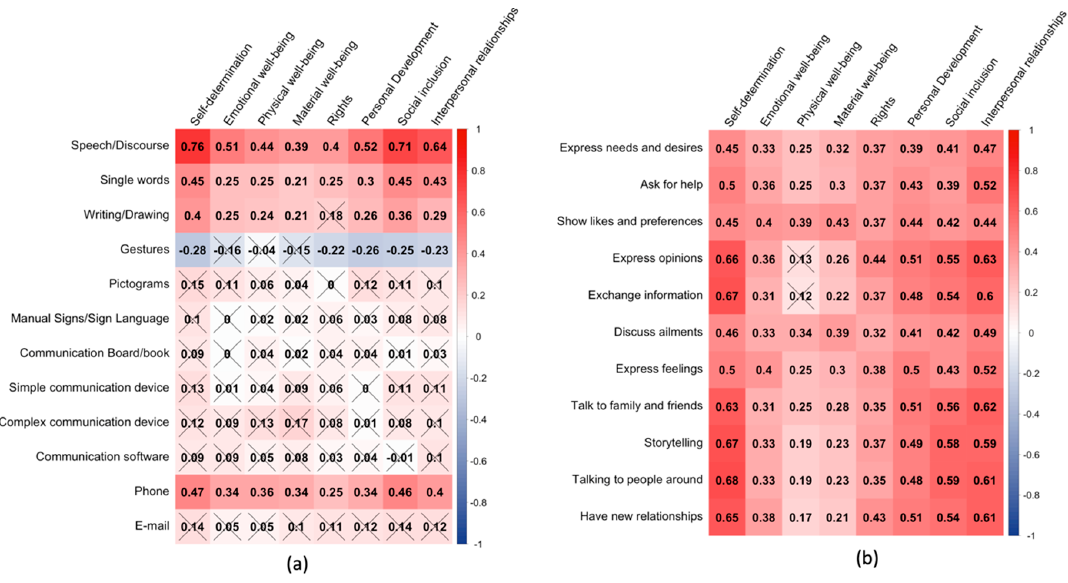
Figure 1. Correlograms representing point-biserial correlations among ( a ) modes of communication and ( b ) purposes of communication and quality of life dimension standard scores. The intensity and color of squares represent the magnitude and sign (red = positive and blue = negative) of the correlation, respectively. A crossed value indicates a non-significant correlation ( p > 0.05; Bonferroni– Holm correction).